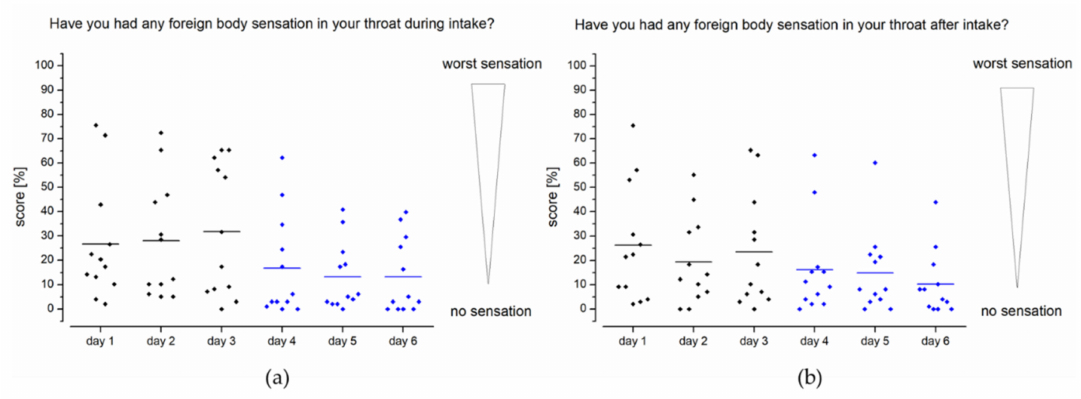
Figure 6. Questionnaire feedback from healthy volunteers (( n = 12) on foreign body sensation during intake ( a ) and after intake ( b ). Study setup A: days 1–3; study setup B: days